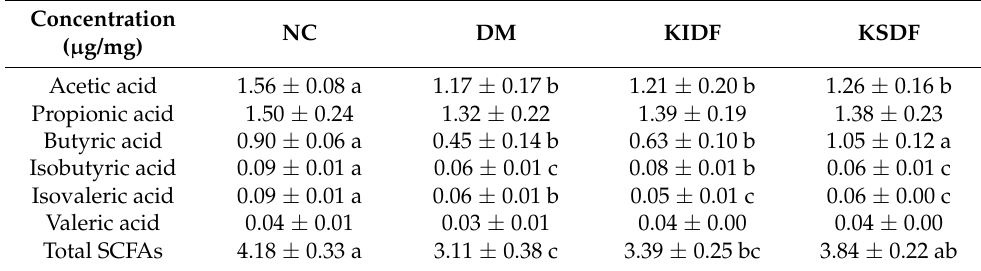
Table 2. Effects of KIDF or KSDF on SCFAs produced in gut.